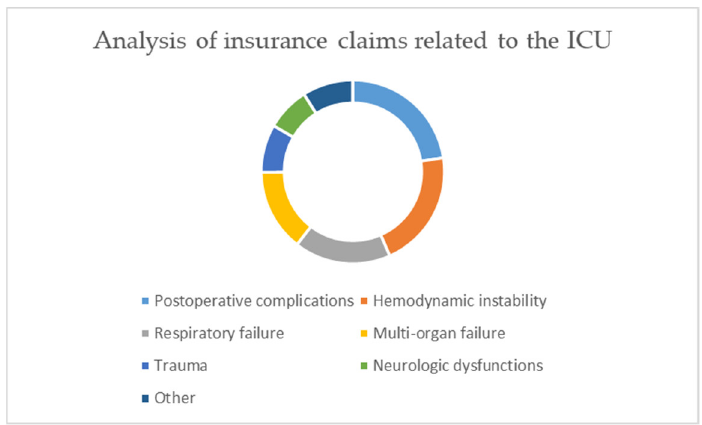
Figure 5. Analysis of insurance claims related to the Intensive Care Units .